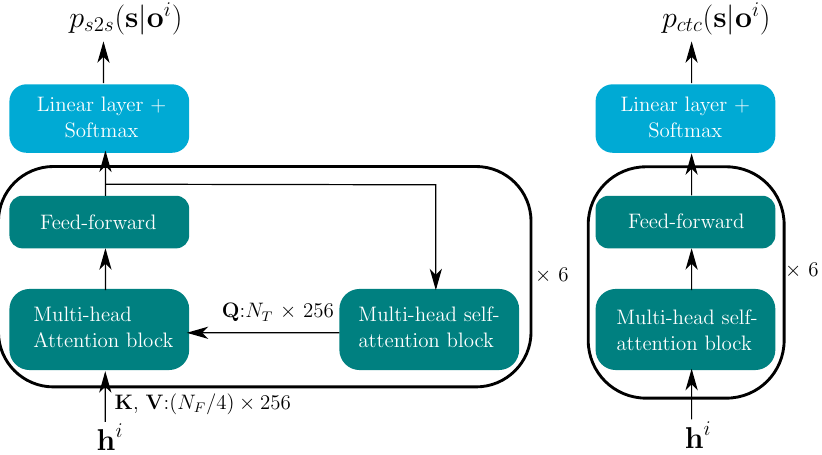
Figure 4. Transformer decoder ( left ) and CTC decoder ( right ) for both modalities i ∈ A,VI.